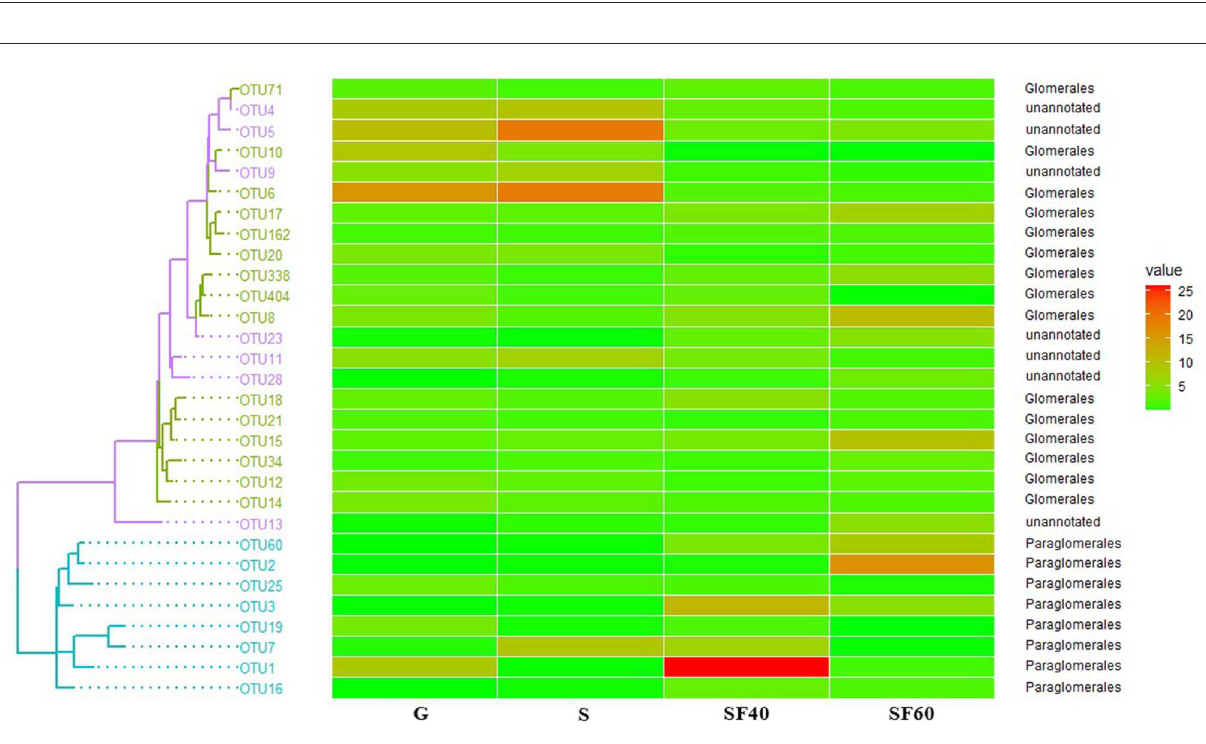
FIGURE6 The phylogenetic tree and heatmap of soil AMF along successional stages, drawn on the basis of the top 30 OUTs. G: grasslands; S: shrubs; SF40: secondary forest of 40a; and SF60: secondary forest of